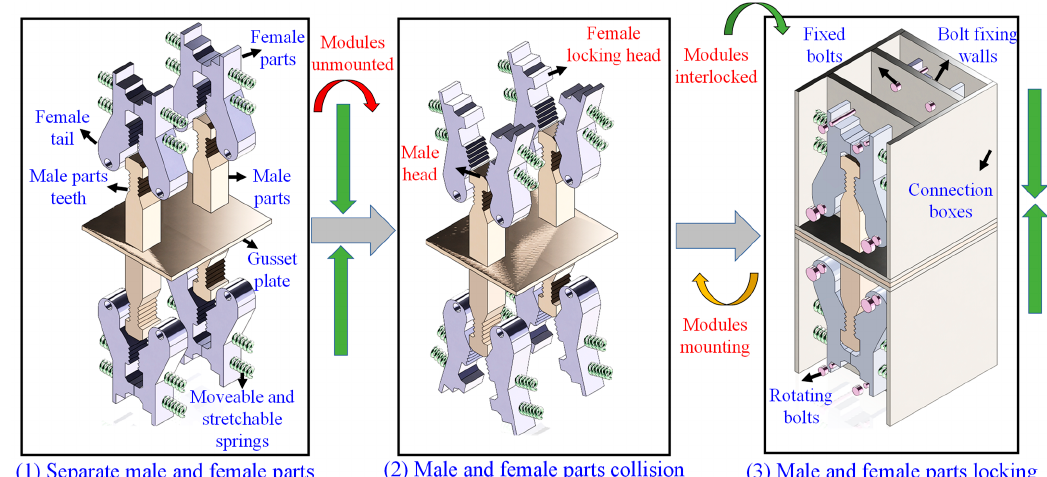
Figure 8. Self-locking automatic vertical column-to-column IMC.